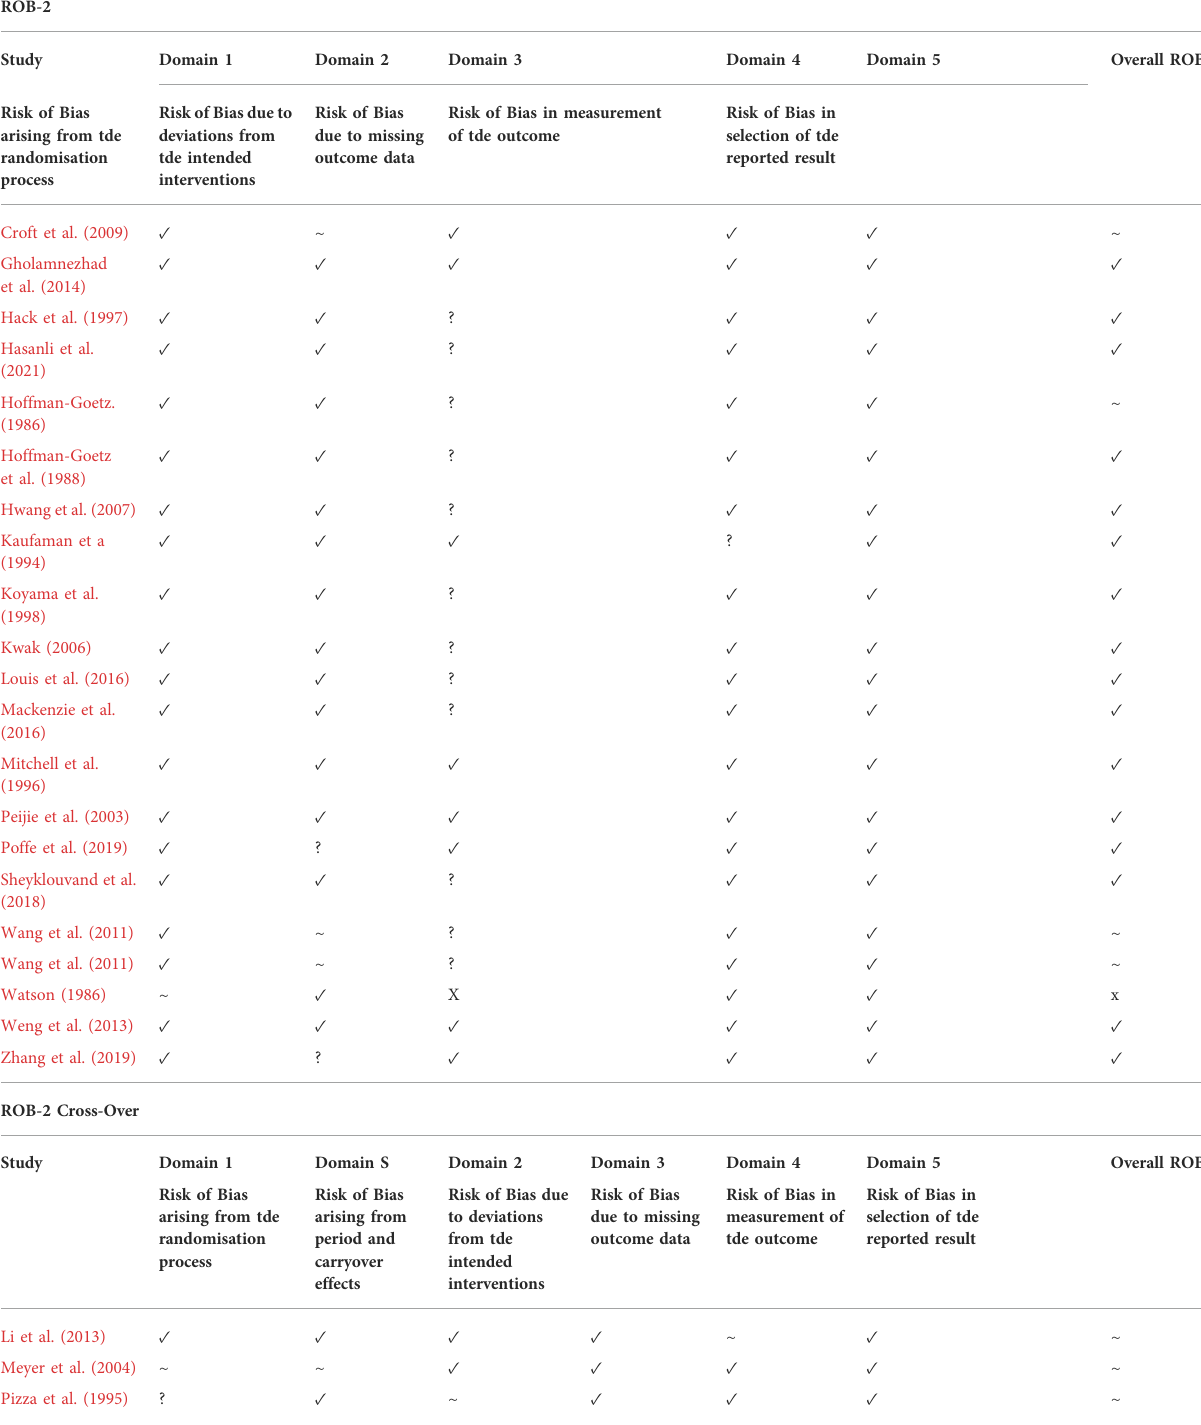
TABLE 1 Risk of Bias assessment of included studies using Cochranes ROB-2, ROBIN-2 Cross-Over and ROBINS-1 tools. ROB-2 and ROB-2 Cross-Over: Low( ✓ ),Someconcern(~),High(X),NotenoughInformation(?).ROBINS-1:Low( ✓